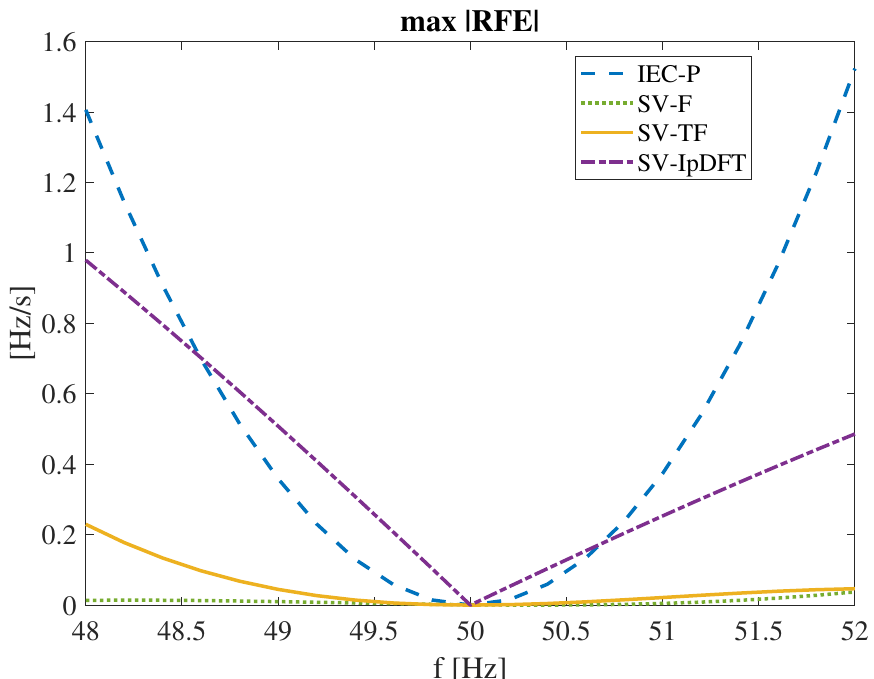
Figure 12. Maximum |RFE| results under off-nominal frequency conditions in the presence of phase-angle